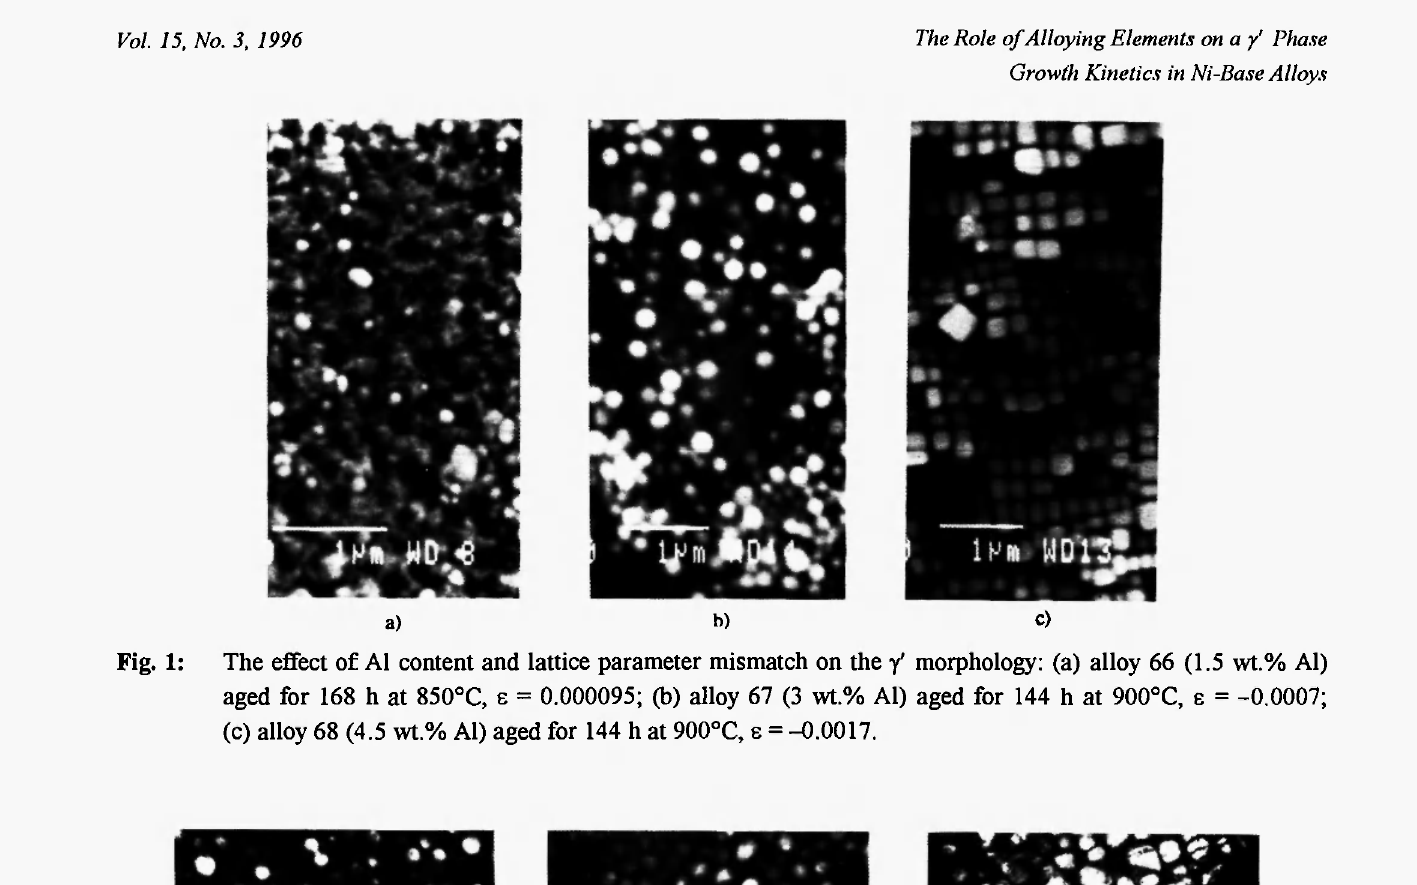
Fig. 1: The effect of Al content and lattice parameter mismatch on the / morphology: (a) alloy 66 (1.5 wt.% Al) aged for 168 h at 850°C, ε = 0.000095; (b) alloy 67 (3 wt.% Al) aged for 144 h at 900°C, ε = -0.0007; (c) alloy 68 (4.5 wt.% Al) aged for 144 h at 900°C, ε = -0.0017.